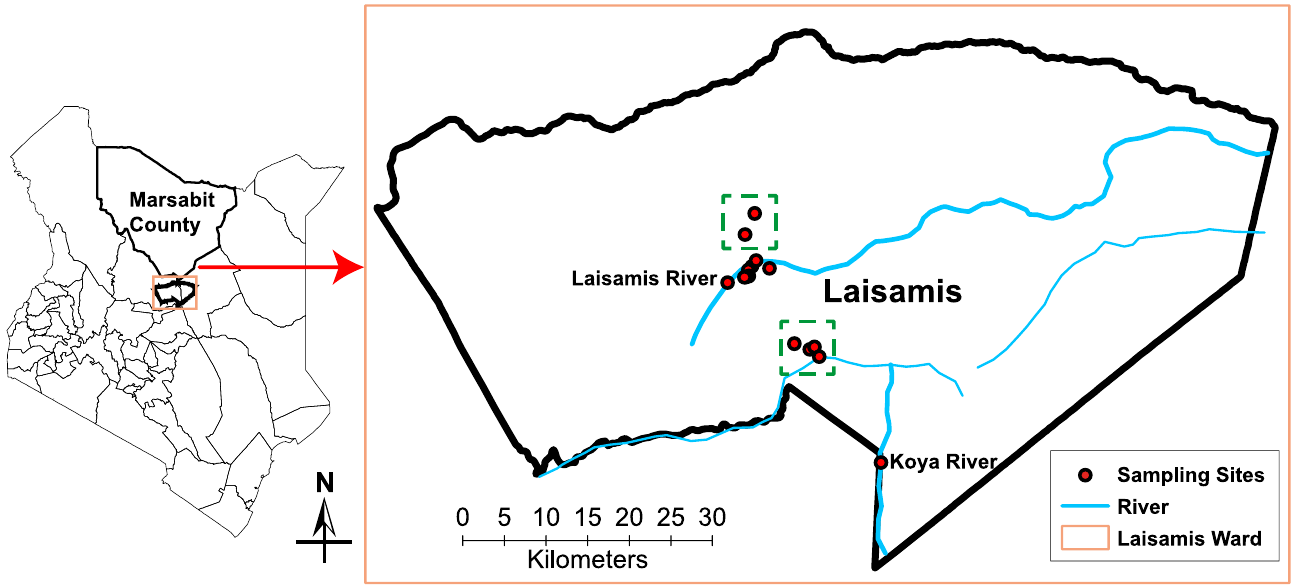
Fig 1. The map of Kenya showing the sampling sites in Laisamis in Marsabit County. The following shapefiles were utilised on the map together with the websites where the data was sourced: Kenya administrative boundaries– https://africaopendata.org/dataset/kenya-counties-shapefile; License: https://www.opendefinition.org/ licenses/cc-by. Rivers–( ke_major-rivers.zip ) https://www.wri.org/resources/data-sets/kenya-gis-data; License:https://www.wri.org/publications/permissions-licensing. All the websites used were under the Creative commons BY 4.0. No base map was used to create the